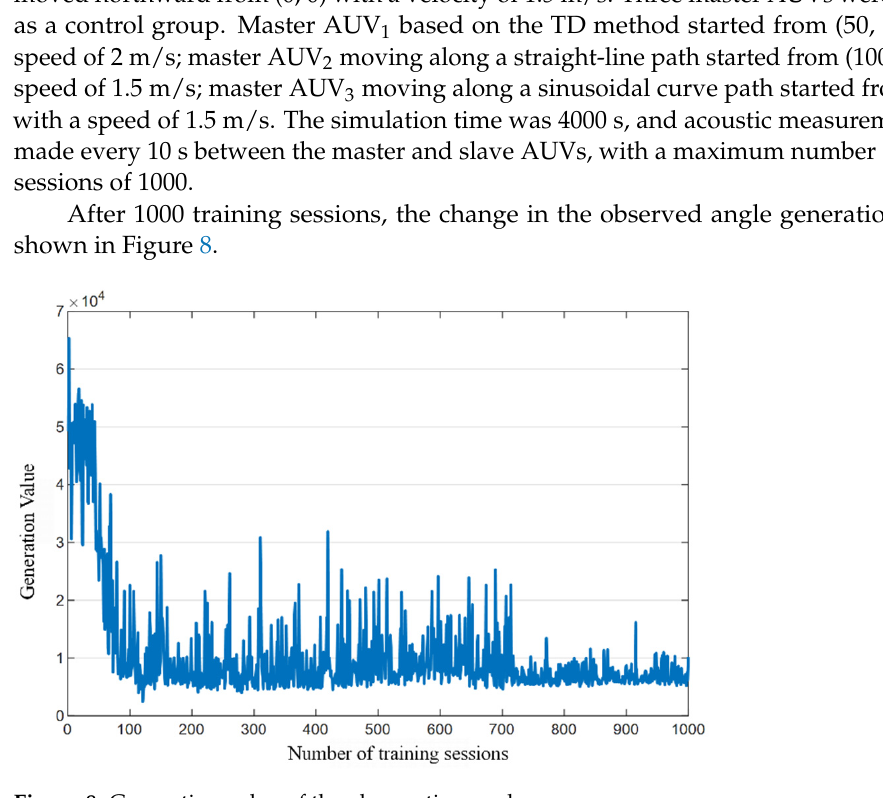
Figure 8. Generation value of the observation angle.